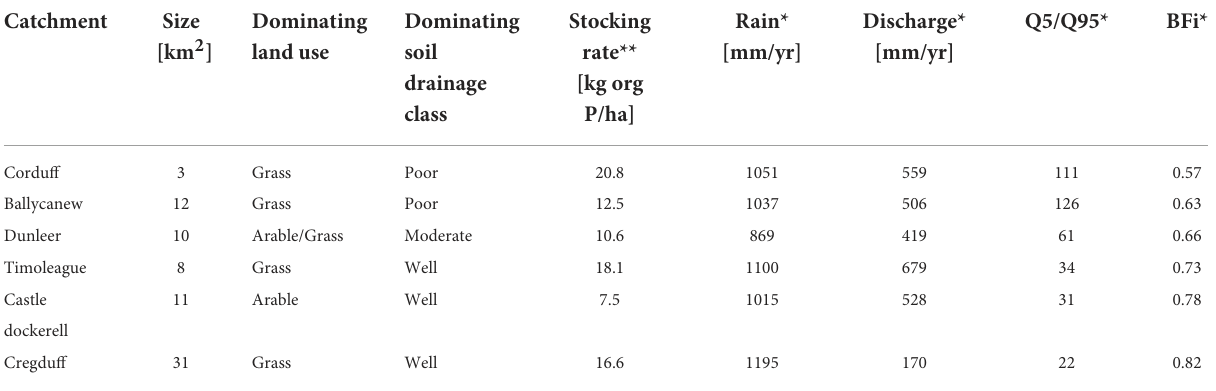
TABLE 1 Description of the six study catchments.